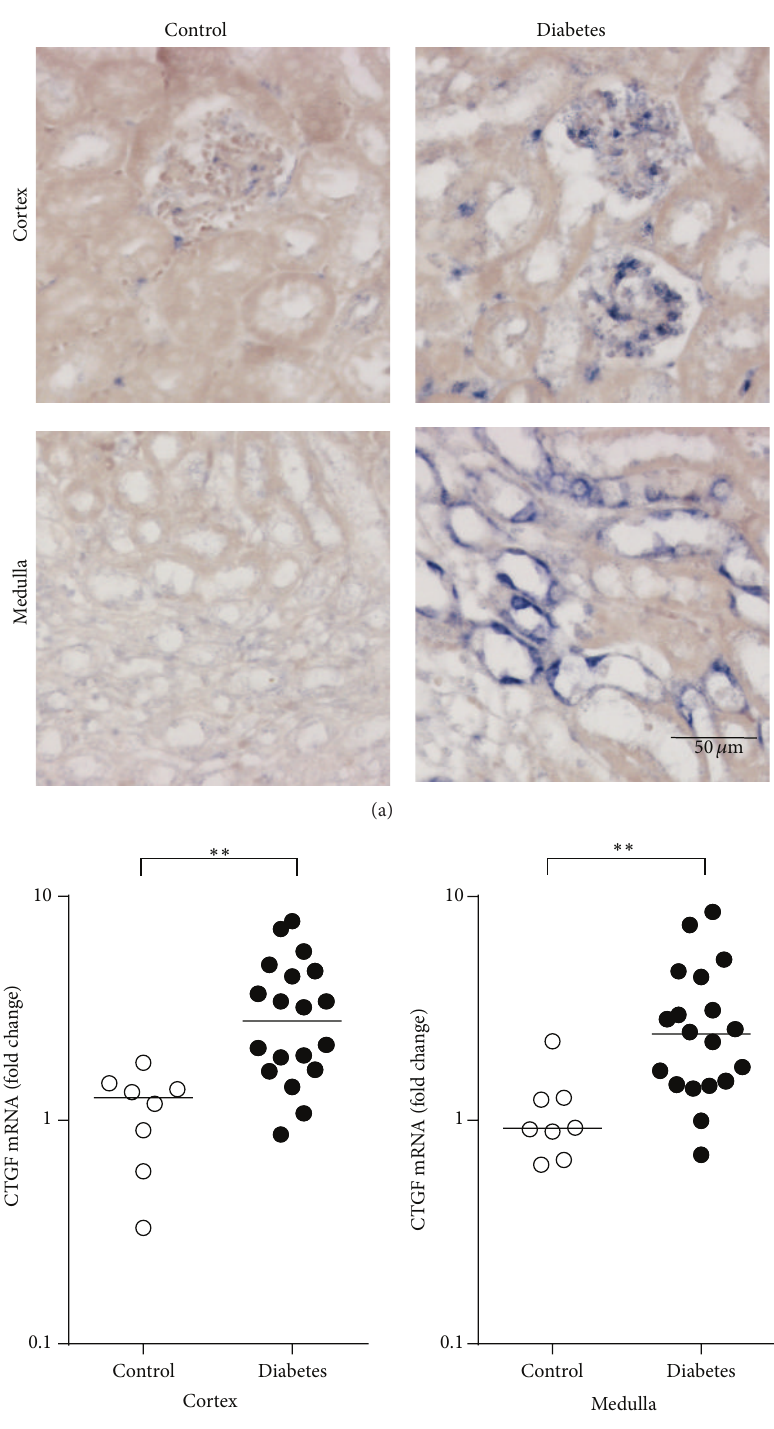
Figure 3: In diabetic kidneys, CTGF mRNA expression is increased in glomeruli and medullary tubules. (a) In situ hybridization of CTGF in control and diabetic mice, with little staining in control mice, and clear staining mainly in glomeruli and medullary tubules. (b) Quantitative RT-PCR of CTGF, showing increased levels in diabetic mice versus control mice, both ∗∗ 𝑃 < 0.01 (Mann-Whitney 𝑈